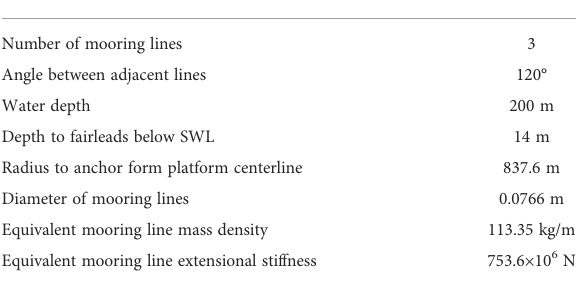
TABLE 3 Properties of the mooring system.